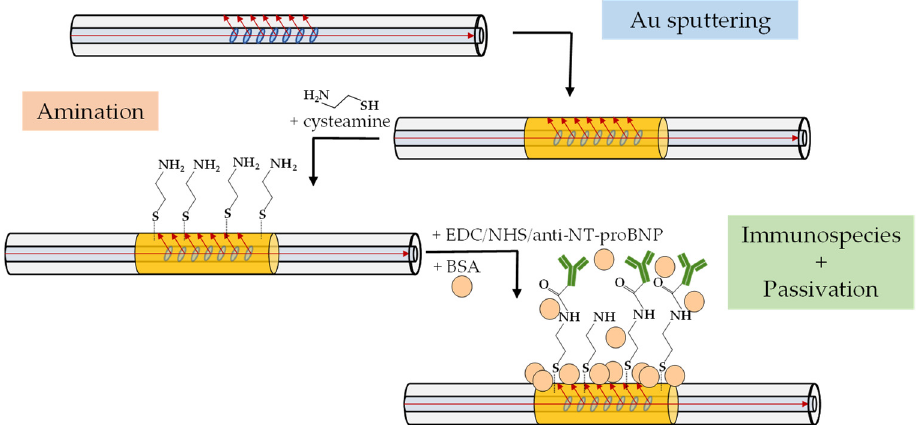
Figure 2. Sketch of the biofunctionalization steps for the Au–TFBG.